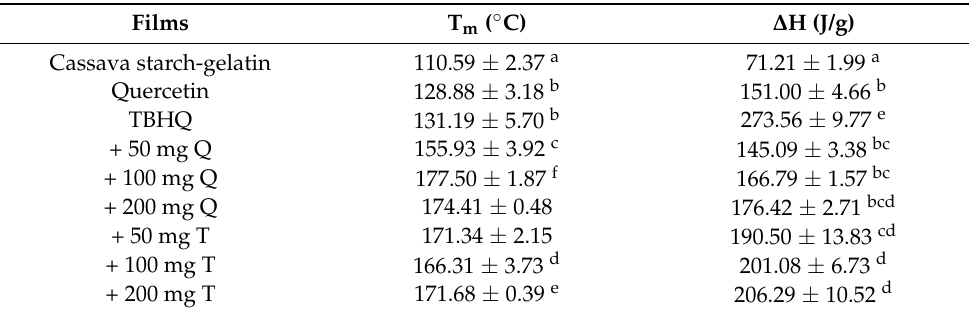
Table 3. Melting temperature (T m ) and heat of fusion ( ∆ H) of cassava starch/gelatin film incorporated with quercetin (Q) and TBHQ (T).